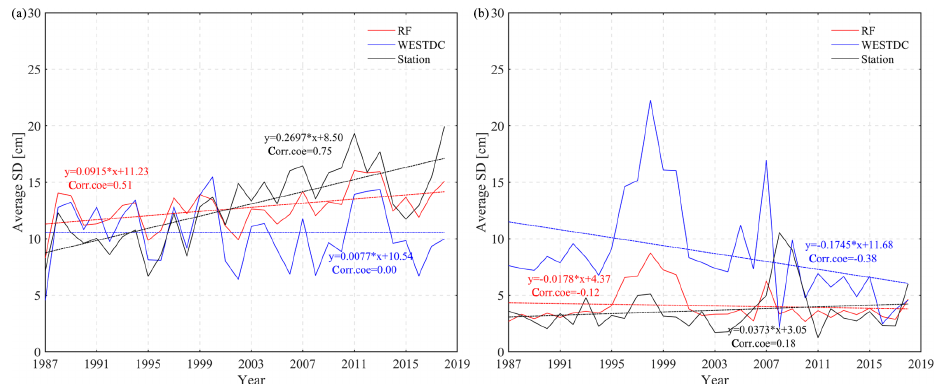
Figure 13. Comparison of changing trends of snow depth between RF estimates and the WESTDC product in specific areas of (a) NEC and (b) the QTP. Table 6. Summary of monthly performances of the RF product in NEC and northern XJ.